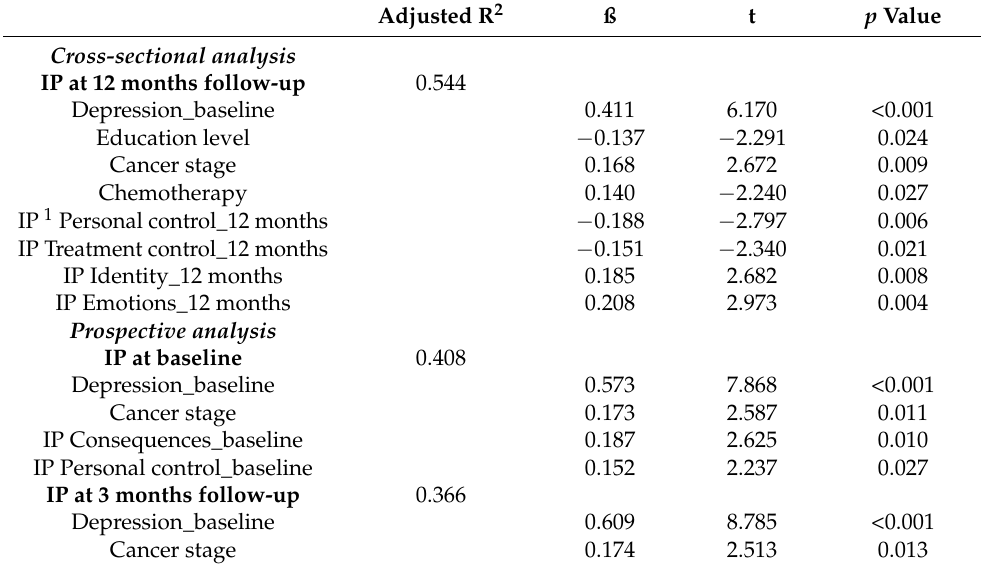
Table 4. Cross-sectional and prospective regression analyses to predict depression at 12 months